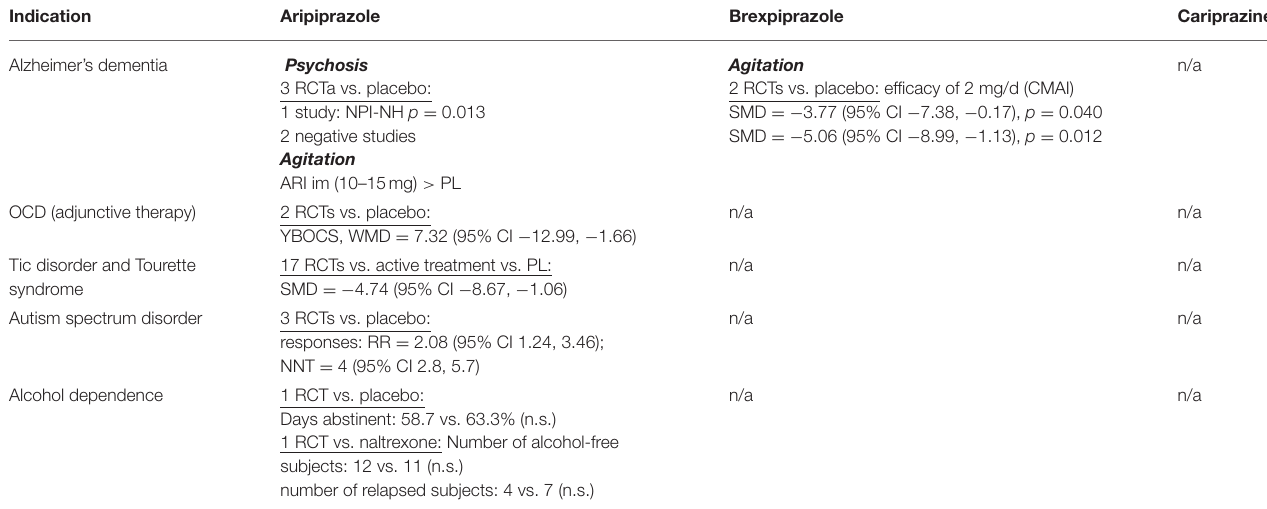
TABLE 4 | Randomized double-blind trials of DRPAs in other indications.